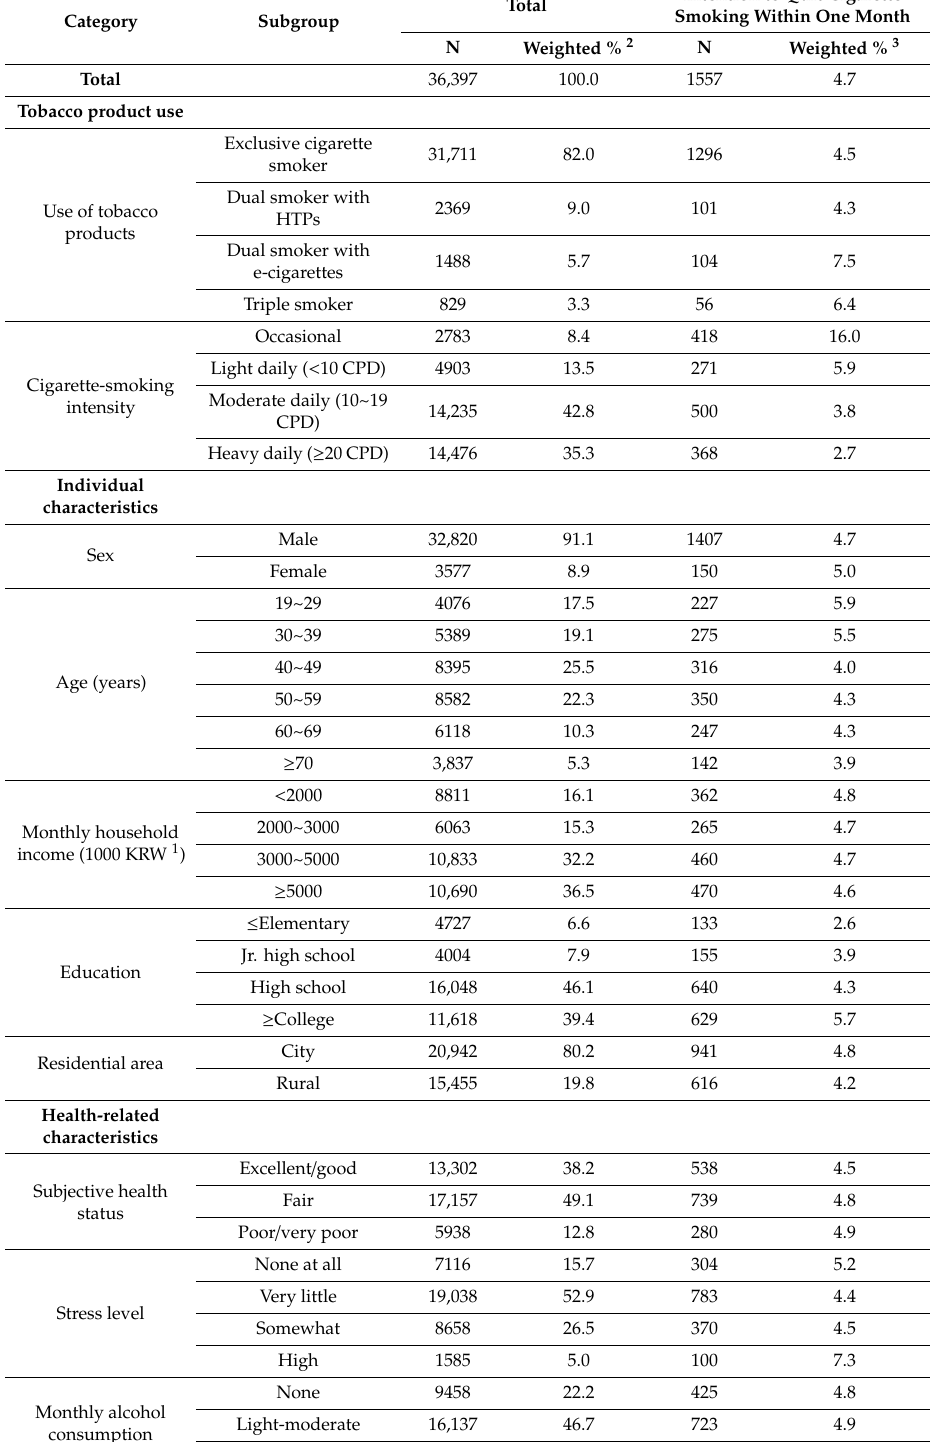
Table 1. Participants’ intention to quit cigarette smoking within one month in terms of tobacco product use and participants’